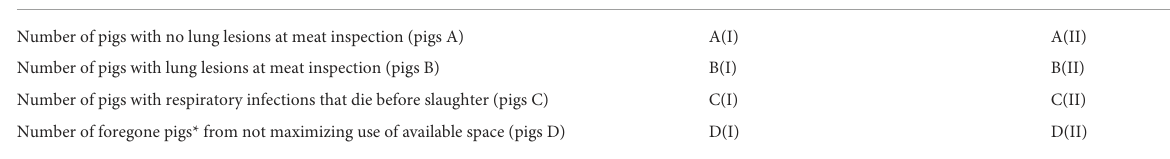
TABLE 4 Categories of finishing pigs used in the partial budget model when either adopting or not adopting the strategy of avoiding mixing litters (S1). Categories of